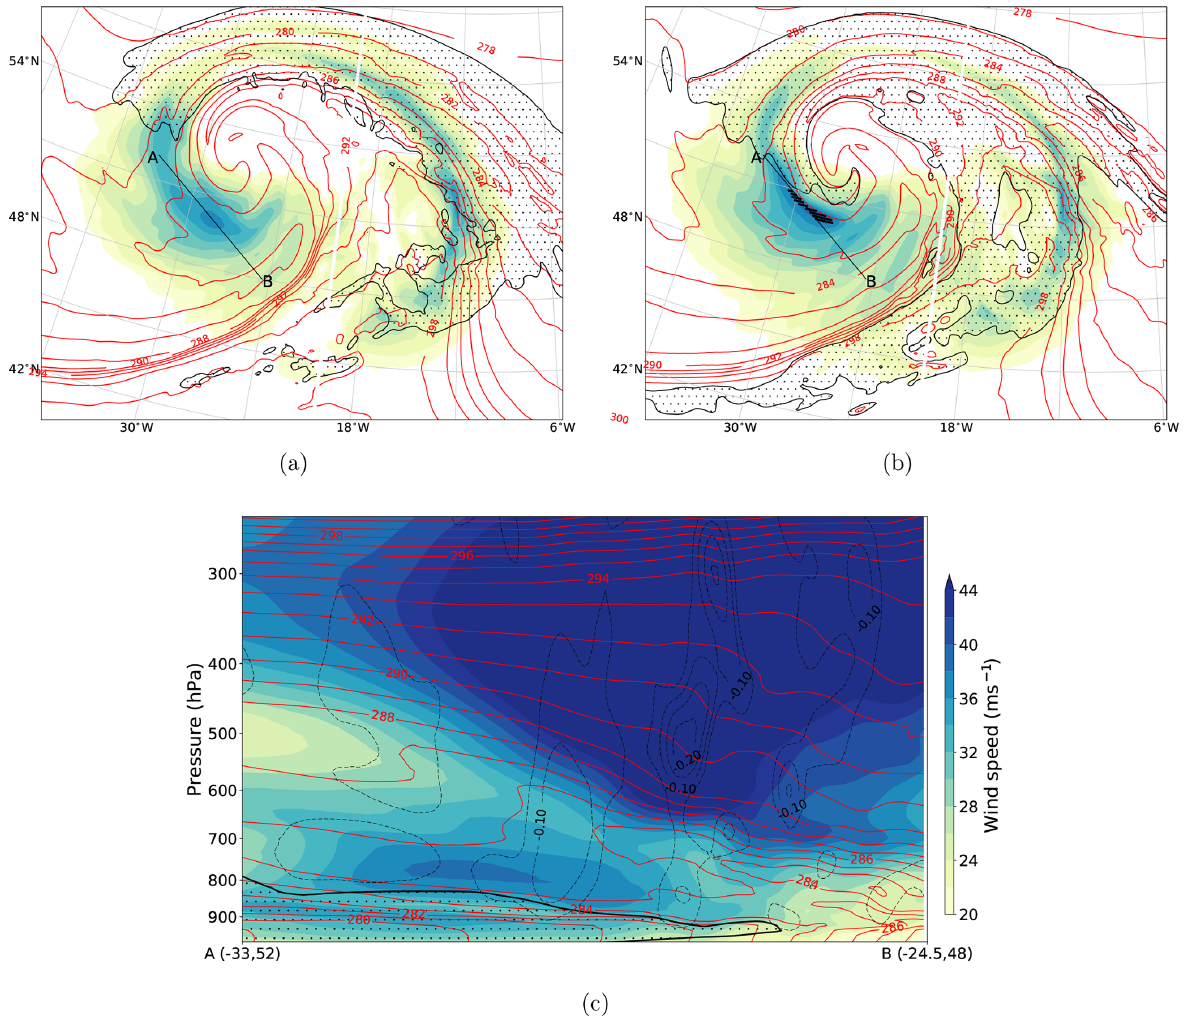
Figure 3. (a) Wind speed at 850hPa (shading; ms − 1 ), θ w at 850hPa (K; red lines) and cloudy regions at 700hPa (RH ice > 80%; black lines and dotted regions) after 94h from the start of the control simulation (as all the other panels in this figure). Note that the model domain (whose original zonal extension goes from 20 ◦ W to 25 ◦ E, with periodic E–W boundary conditions) is repeated zonally to facilitate visualisation, but only data between 45 and 5 ◦ W are shown here. (b) Same as panel (a) but at 805hPa for all fields. Black dots show the horizontal locations of SJ trajectories. (c) Cross section (transect AB in panel a ) of wind speed (green filled contours), negative vertical velocity (dashed black lines; ms − 1 ), θ w (red lines; K) and cloudy regions (RH ice > 80%; thick black